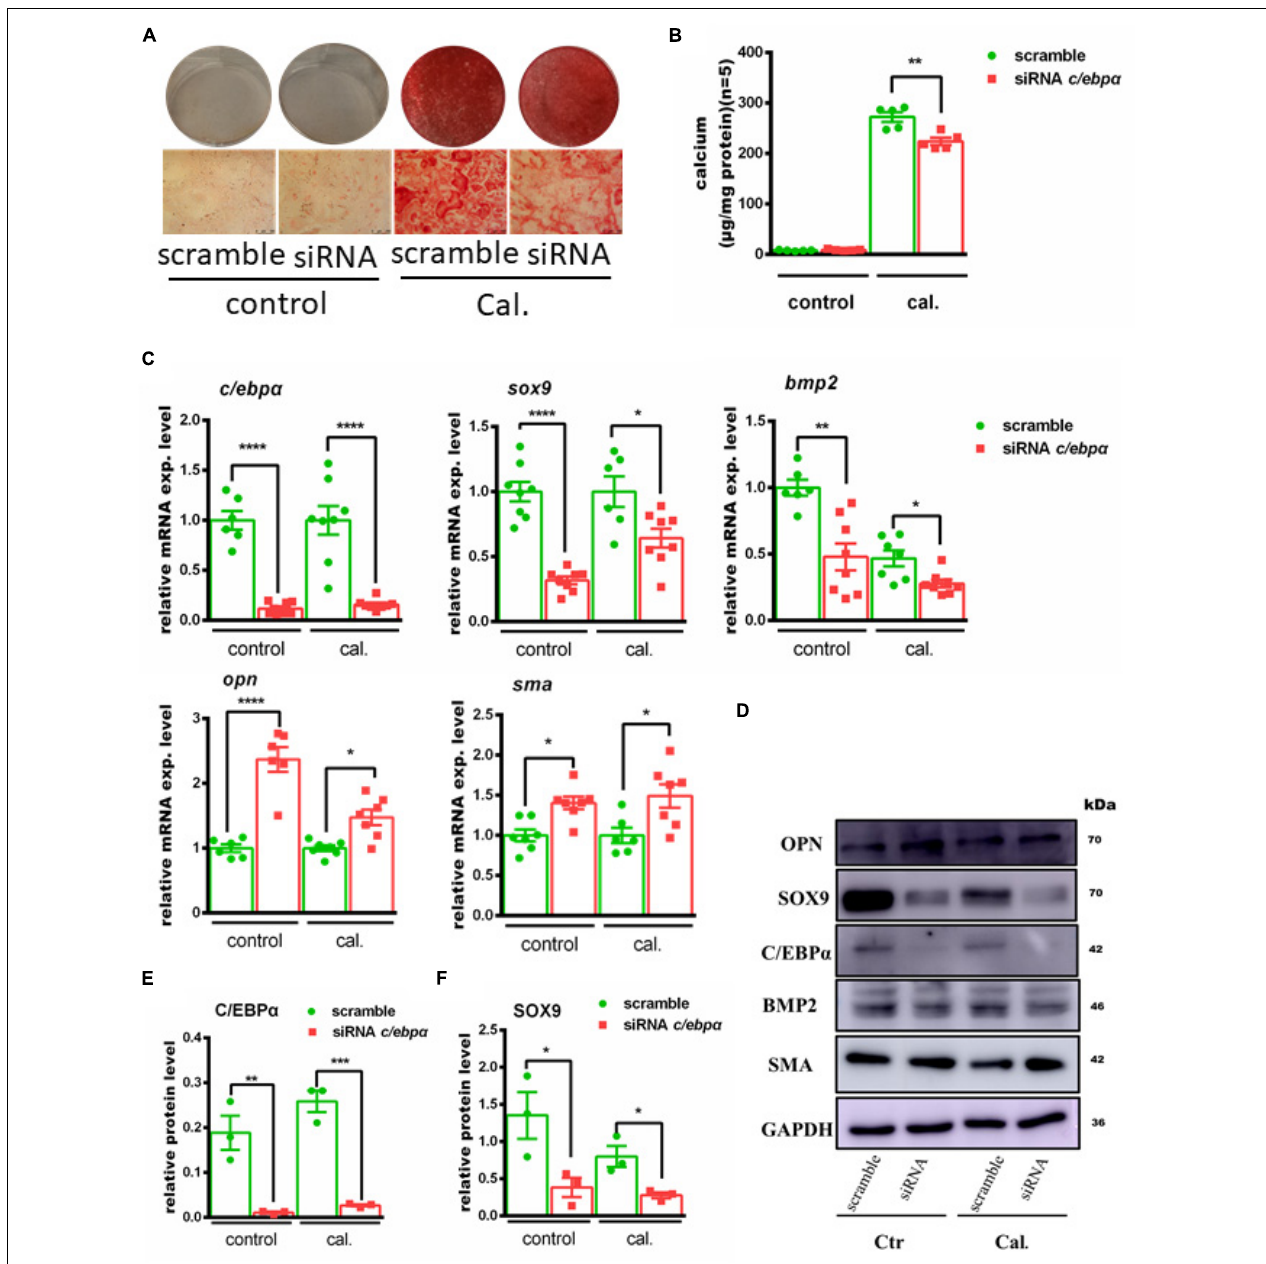
FIGURE 3 | Silencing the c/ebp α inhibits calcium-/phosphate-induced vascular calcification. (A) Representative images of alizarin red staining confirmed calcium deposition in primary VSMCs transfected with 25 nM scrambled or siRNA c/ebp α treated with calcium/phosphate or control medium. Typical areas at 10 × magnifications are placed beside the respective panels. (B) Quantitative calcium assay for VSMCs transfected with 25 nM scrambled or siRNA c/ebp α treated with calcium/phosphate or control medium ( n = 5). (C) Real-time PCR analysis for the mRNA expression of Bmp2 , Sox9 , Opn , Opg , Sma , and c/ebp α in VSMCs vascular calcification for the indicated experimental groups. The target mRNAs were normalized to β -actin mRNA and are graphed ( n = 8). (D) Western blotting analysis of VSMCs vascular calcification for the indicated proteins. Indicated protein expression was normalized to GAPDH. (E,F) Semiquantitative analysis of Western blotting for C/EBP α and SOX9 protein expression using ImageJ software ( n = 3). * p < 0.05, ** p < 0.01, *** p < 0.001, **** p < 0.0001.